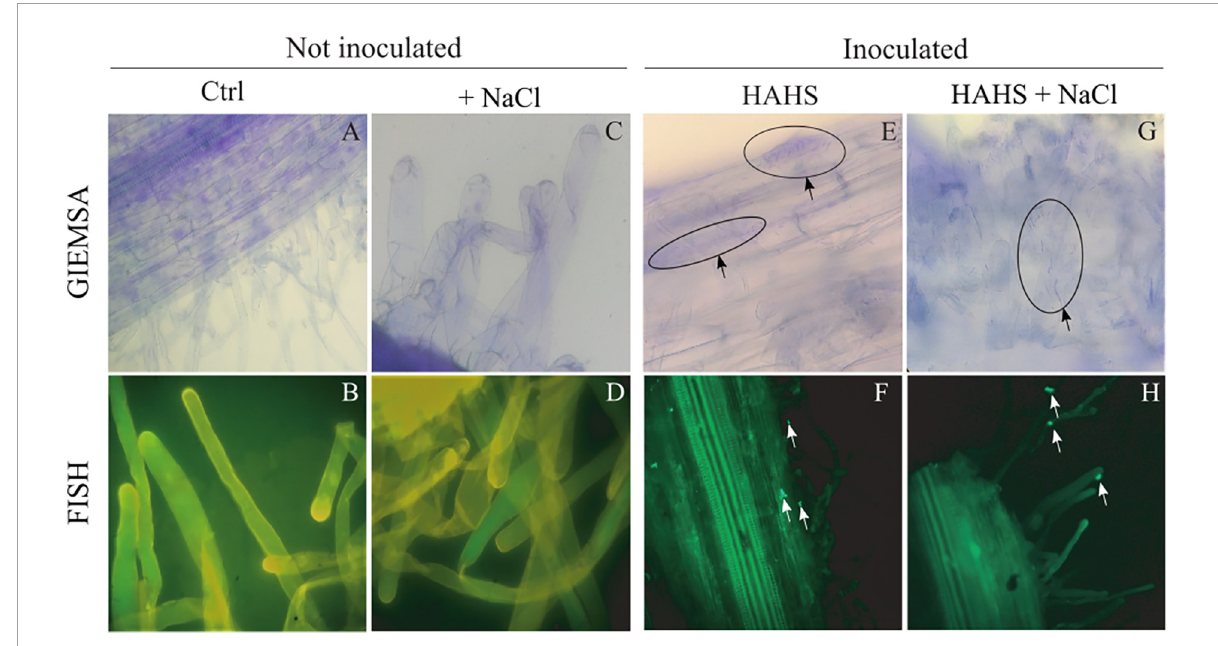
FIGURE2 Colonization of Salinispora arenicola on tomato root hairs. Samples underwent Giemsa staining (A,C,E,G) and Fluorescence in situ Hybridization (FISH; B , D , F , H ). Arrows indicate the presence of habitat-adapted heterologous symbiont (HAHS) bacterial cells in samples of plants inoculated under control (Ctrl; without NaCl) and NaCl conditions (100 mM).